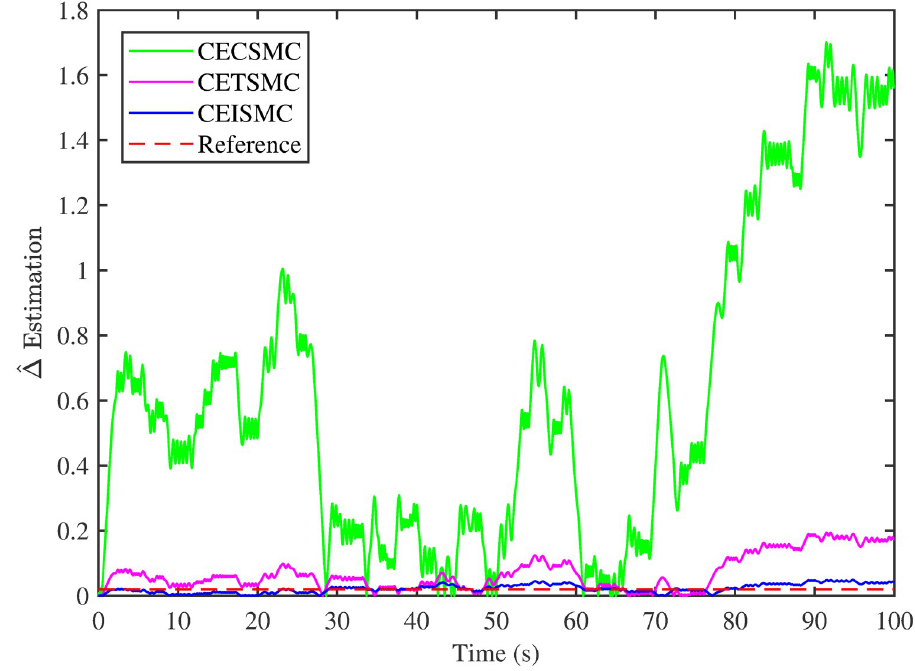
Fig 3. Delta estimation versus time.